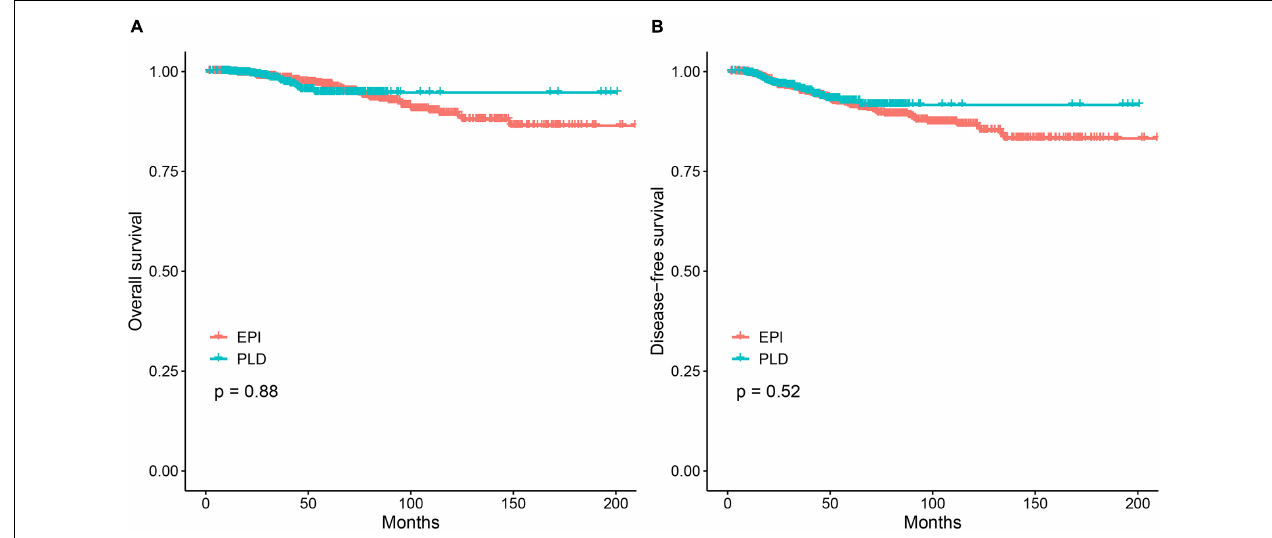
FIGURE 1 | The Kaplan–Meier analysis for the PLD-based regimen vs. the epirubicin-based regimen. (A) Comparison of OS between the two regimens. (B) Comparison of DFS between the two regimens. PLD, pegylated liposomal doxorubicin; EPI,